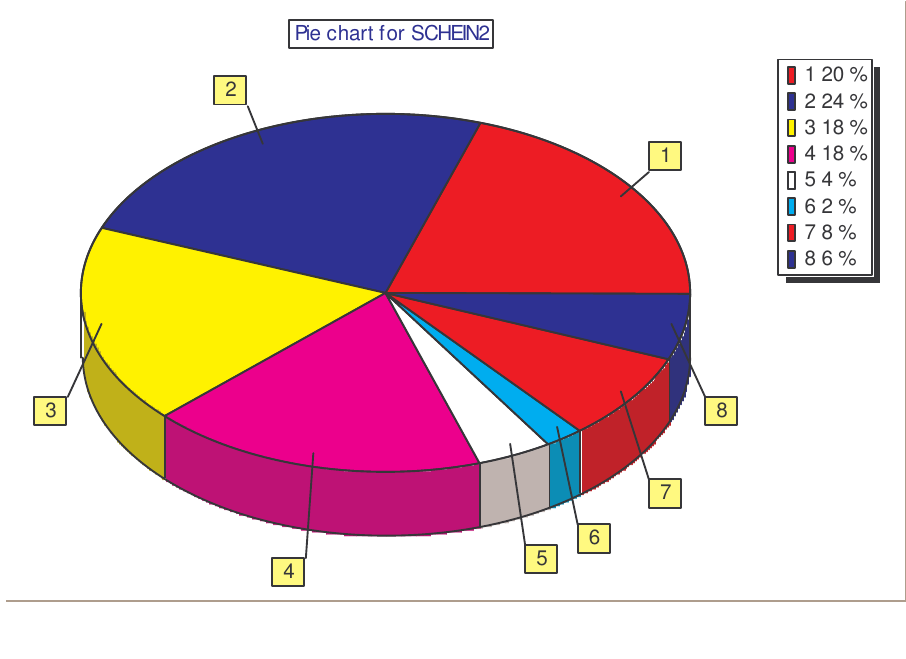
Figure 2: The secondary career anchors of participants